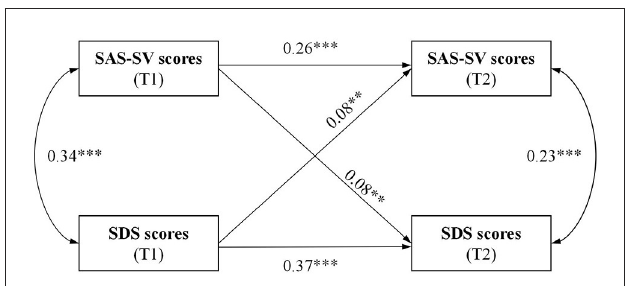
FIGURE1 CLPM of SAS-SV and SDS scores at baseline (T1) and follow-up (T2, over 12 months) with standardized path coefficients. ** P < 0.01; *** P < 0.001; T1 = assessed at baseline, T2 = assessed at follow-up. SAS-SV, Smartphone Addiction Scale-Short Version; SDS, Zung’s Self-Rating Depression Scale; Single-headed arrows denote regressions, double-headed arrows denote correlations.